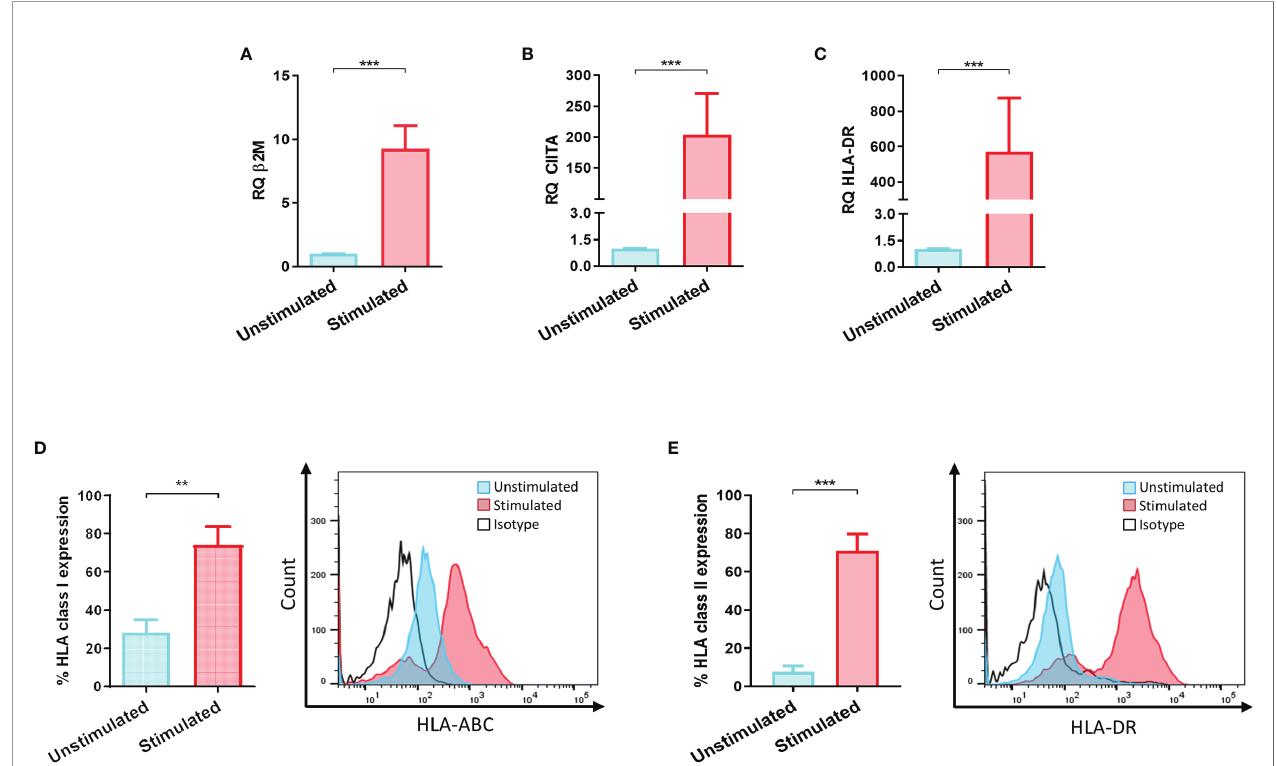
FIGURE 1 | In fl ammatory microenvironment promotes upregulation of HLA antigens on limbal stem cells. (A) HLA class I codominant domain b 2-microglobulin ( b 2M), (B) HLA class II transactivator (CIITA) and (C) HLA-DR transcripts upregulated on limbal stem cells (LSCs) after 48 hours stimulation with IFN g (100ng/mL). (D, E) Surface mean expression of HLA class I and class II molecules on LSCs in absence and presence of IFN g stimulation. Student ’ s t-test was used to compared differences between groups and data are presented as mean ± SD, n = 5, **p < 0.01, ***p <